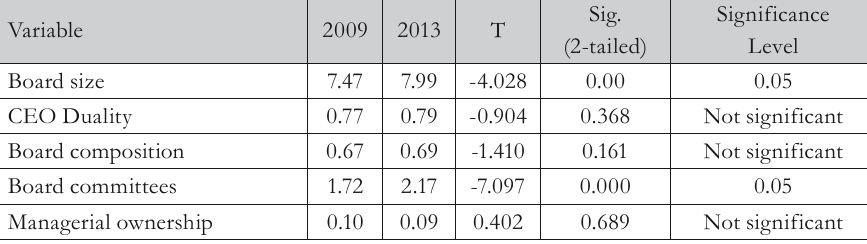
Tab. 3 - Results of Paired sample t-test. Source: Data analysis